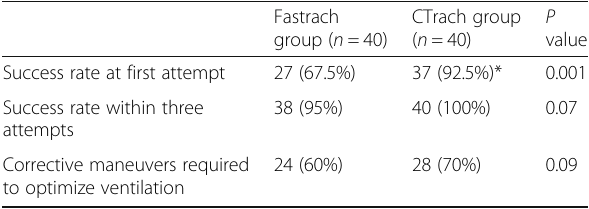
Table 2 Success rates of intubation as number